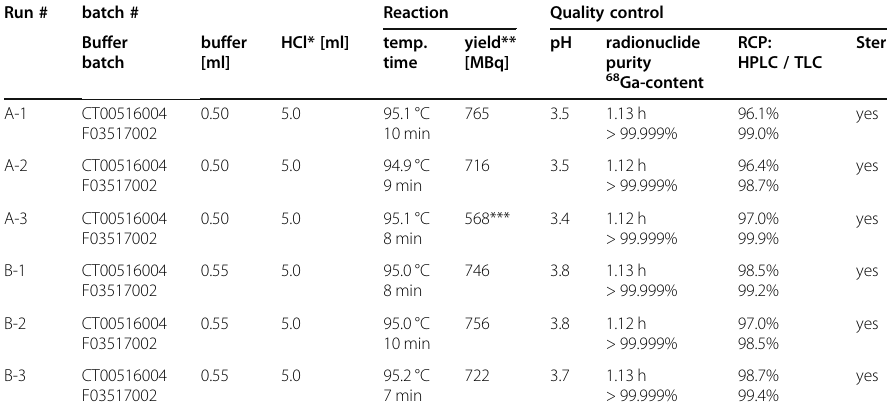
Table 2 Results of the validation runs of [ 68 Ga]Ga-NeoB Run # batch # Reaction Quality